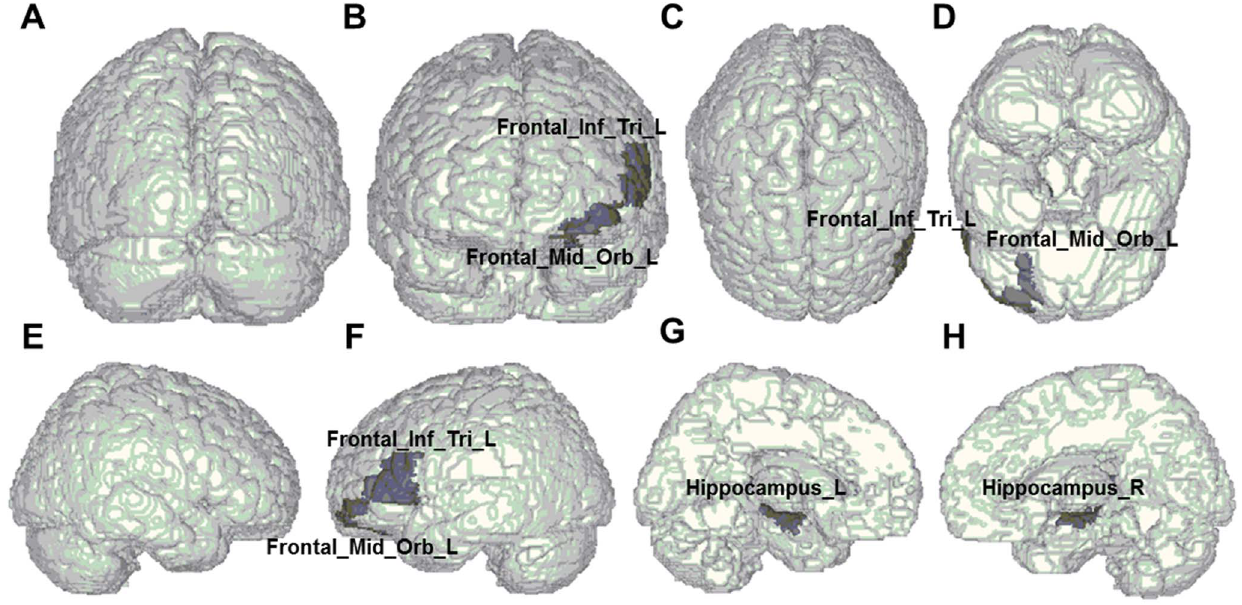
Figure 3. Anatomical regions exhibiting significant differences of cortical shape complexity between remitting and non-remitting depressed patients. The regions showing significant differences were the sulcal pits of the orbital part of left middle frontal gyrus (Frontal_Mid_Orb_L), the gyral saddle areas of the triangular part of left inferior frontal gyrus (Frontal_Inf_Tri_L), the gyral nodes of left hippocampus (Hippocampus_L), and the sulcal pits of right hippocampus (Hippocampus_R) as shown in (A) posterior, (B) anterior, (C) superior, (D) inferior (E) right- lateral, (F) left-lateral, (G) left-medial, and (H) right-medial views.